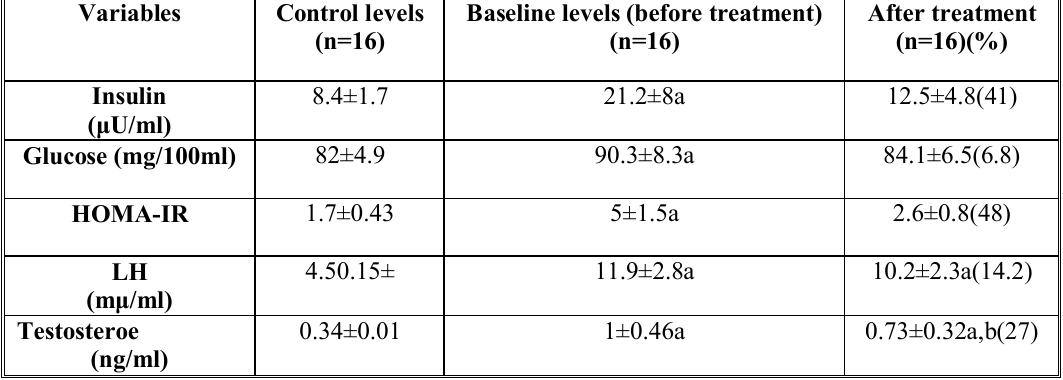
Table (4): Effect of treatment with the combination of metformin(1500 mg /d) and rosiglitazone (4mg/d) on the levels of insulin , glucose , HOMA-IR,LH and testosterone in group ΙΙ.